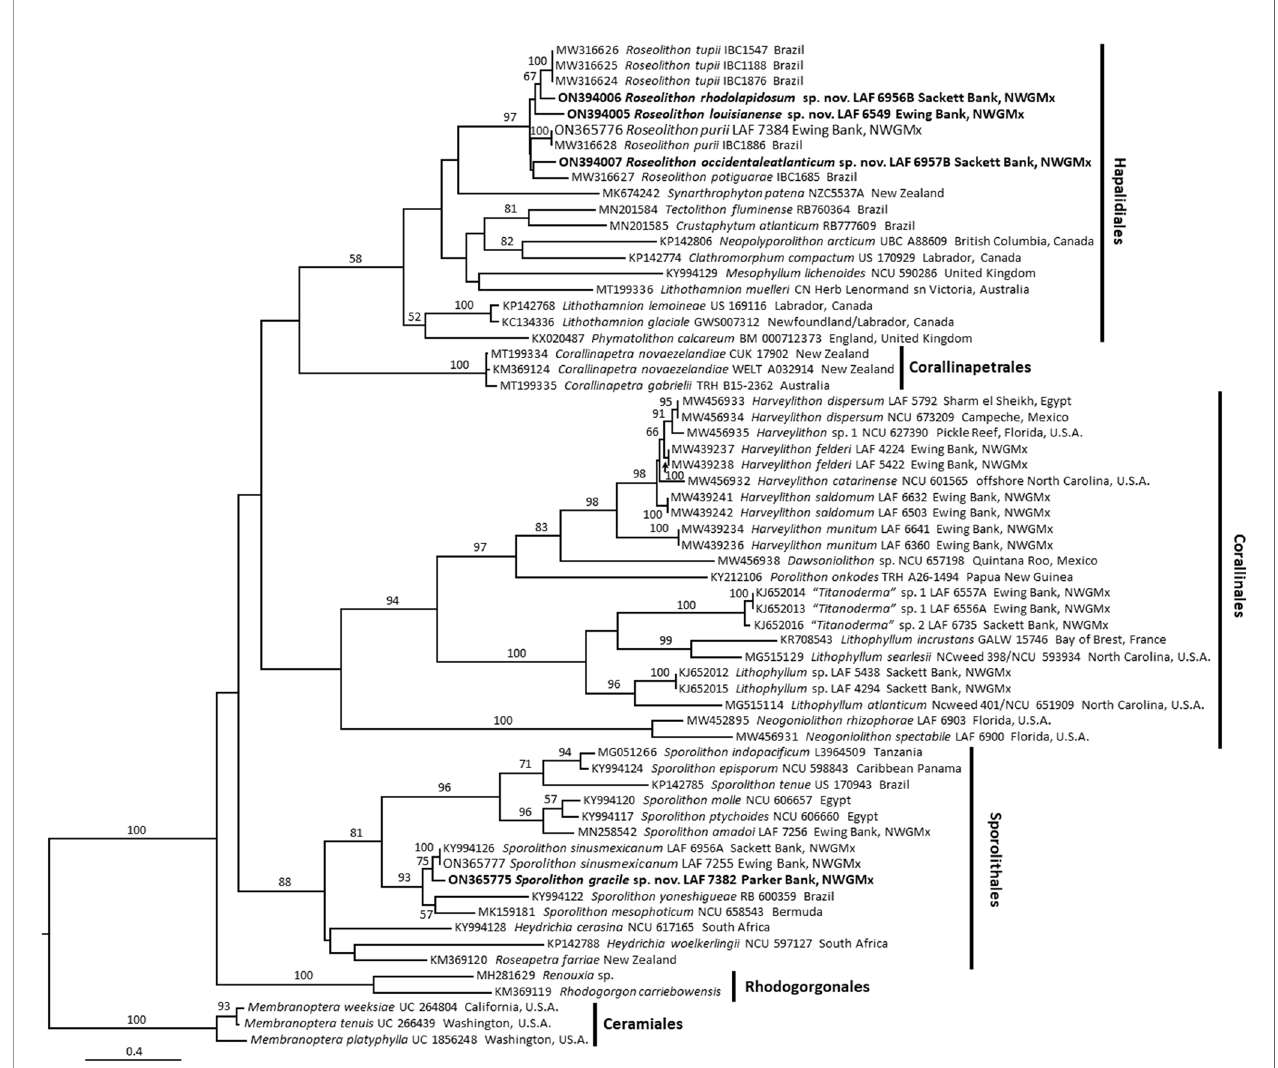
FIGURE 2 | Maximum Likelihood analyses of rbc L. Node values represent bootstrap values out of 1,000 replicates. Newly described species shown in bold. NWGMx, northwestern Gulf of